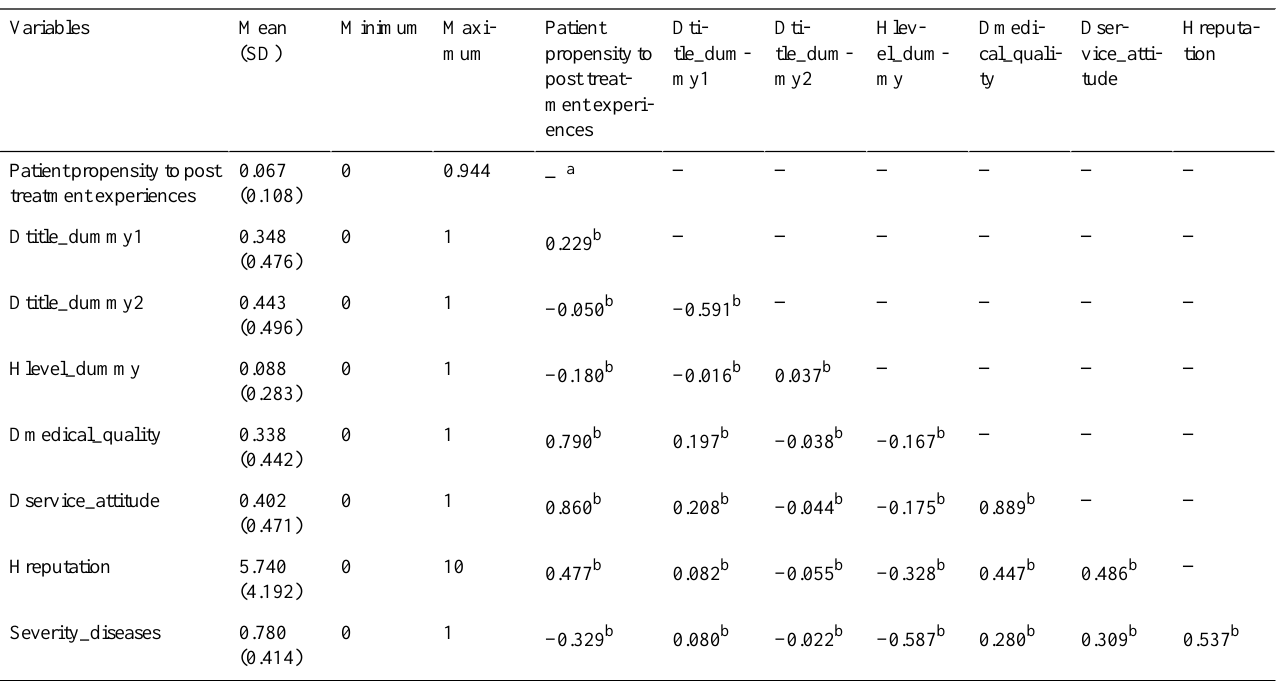
Table 2. Description and correlation